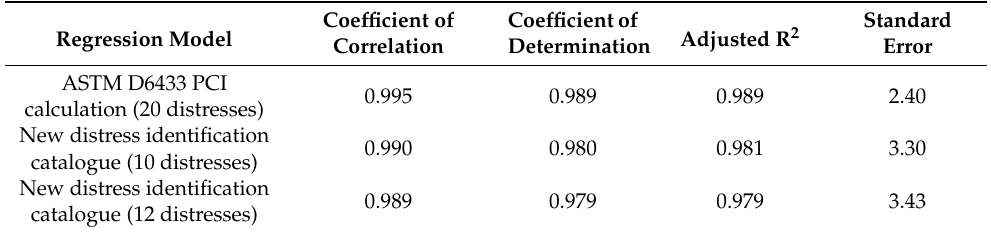
Table 7. Regression coefficient of the automated procedure for PCI calculation